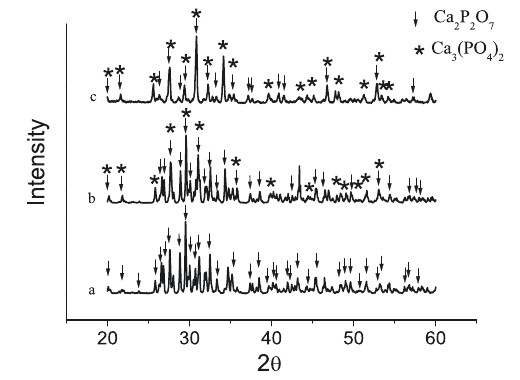
Figure 6. XRD for the samples from powders synthesized from (NH